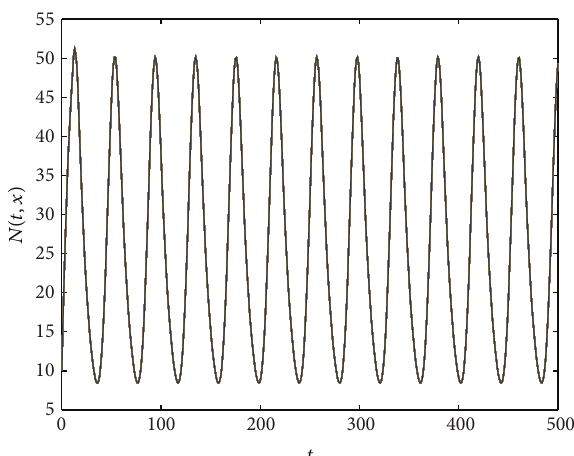
Figure 5: Parameters: 𝛿 = 0.1 , 𝑝 1 = 3 , 𝑝 2 = 2 , 𝑎 = 0.2 , 𝜏 1 = 12 , = 15 , and 𝑁 ∗ = 19.5601 . Initial condition is 𝜓(𝜃,𝑥) = 10 + sin 𝜃 , 𝜏 2 (𝜃,𝑥) ∈ [−15,0] × [0, 1]